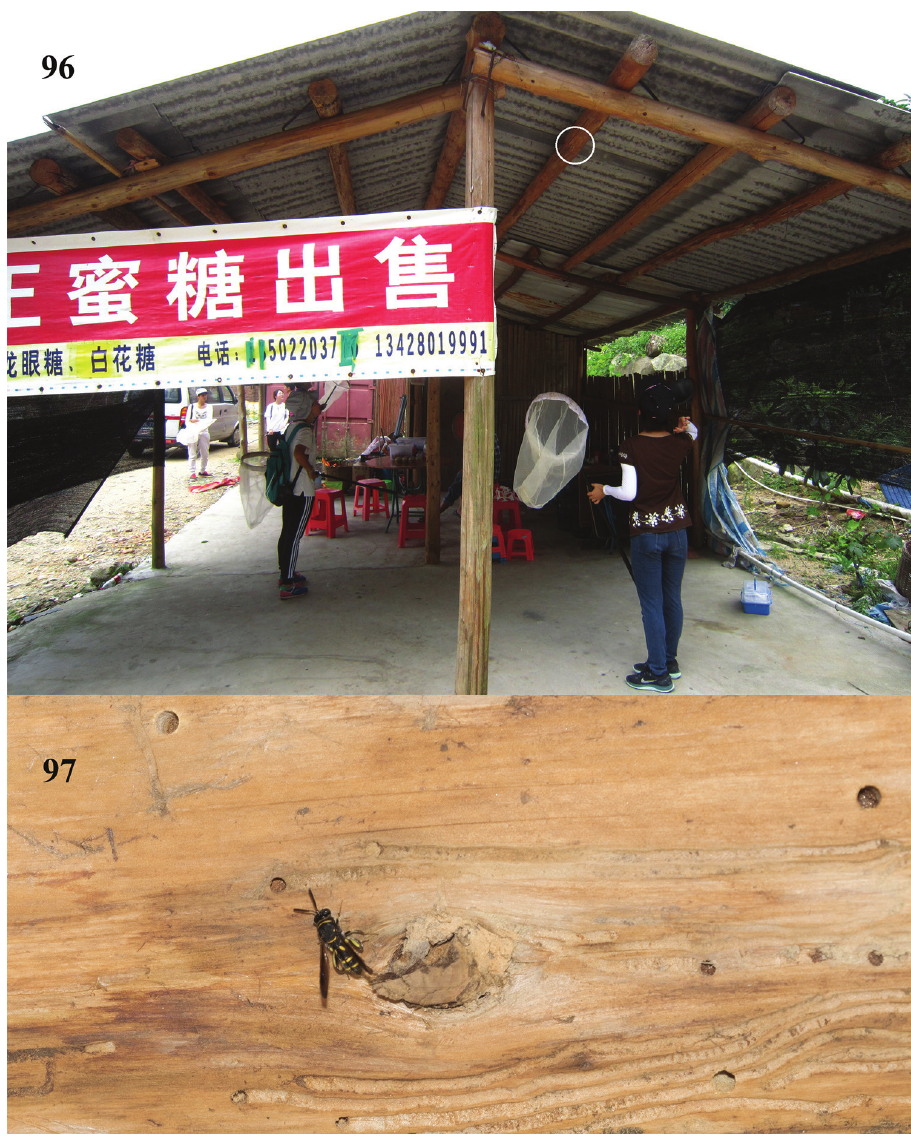
Figures 96, 97. Female Leucospis histrio Maindron searching on timber of wooden shed in Guangdong, Xiangtoushan (courtesy of Mr. Wei